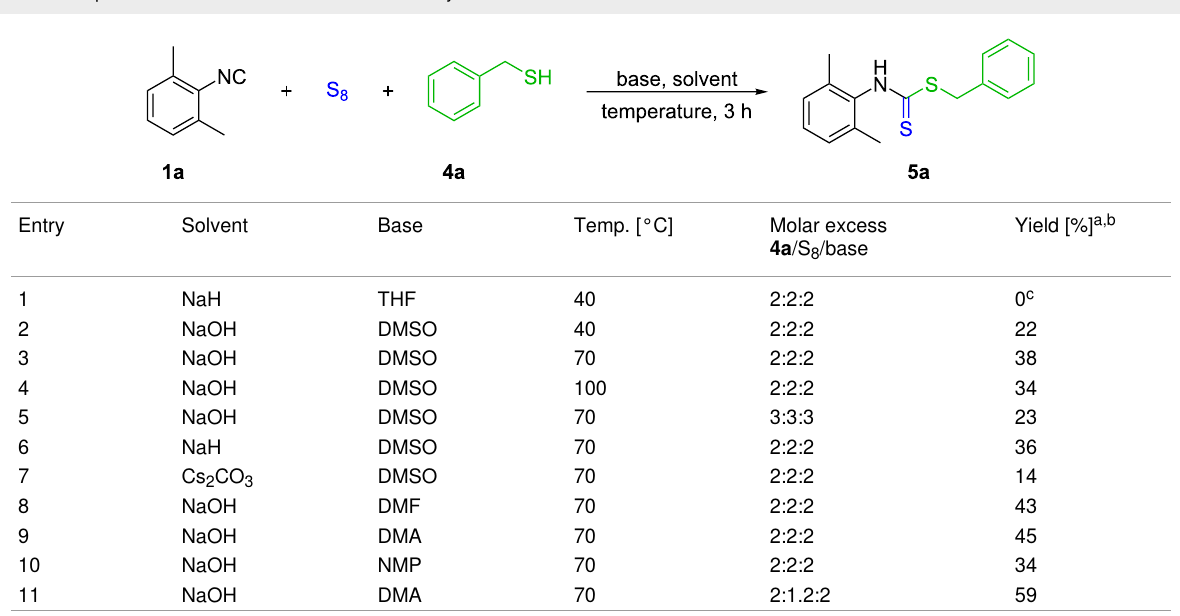
Table 2: Optimization of the reaction conditions for the synthesis of